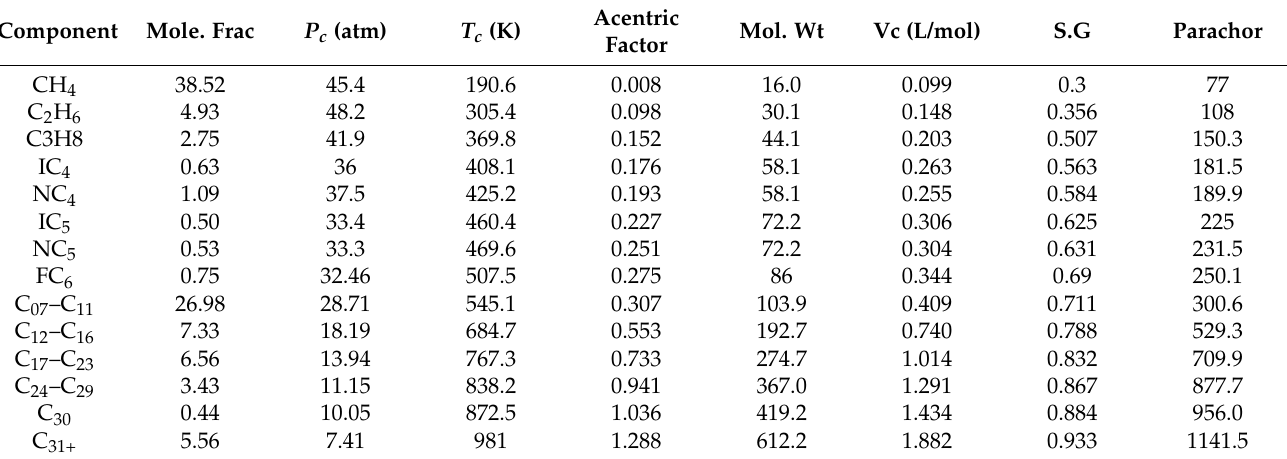
Table 2. Extended PVT properties of the representative base case reservoir fluid.